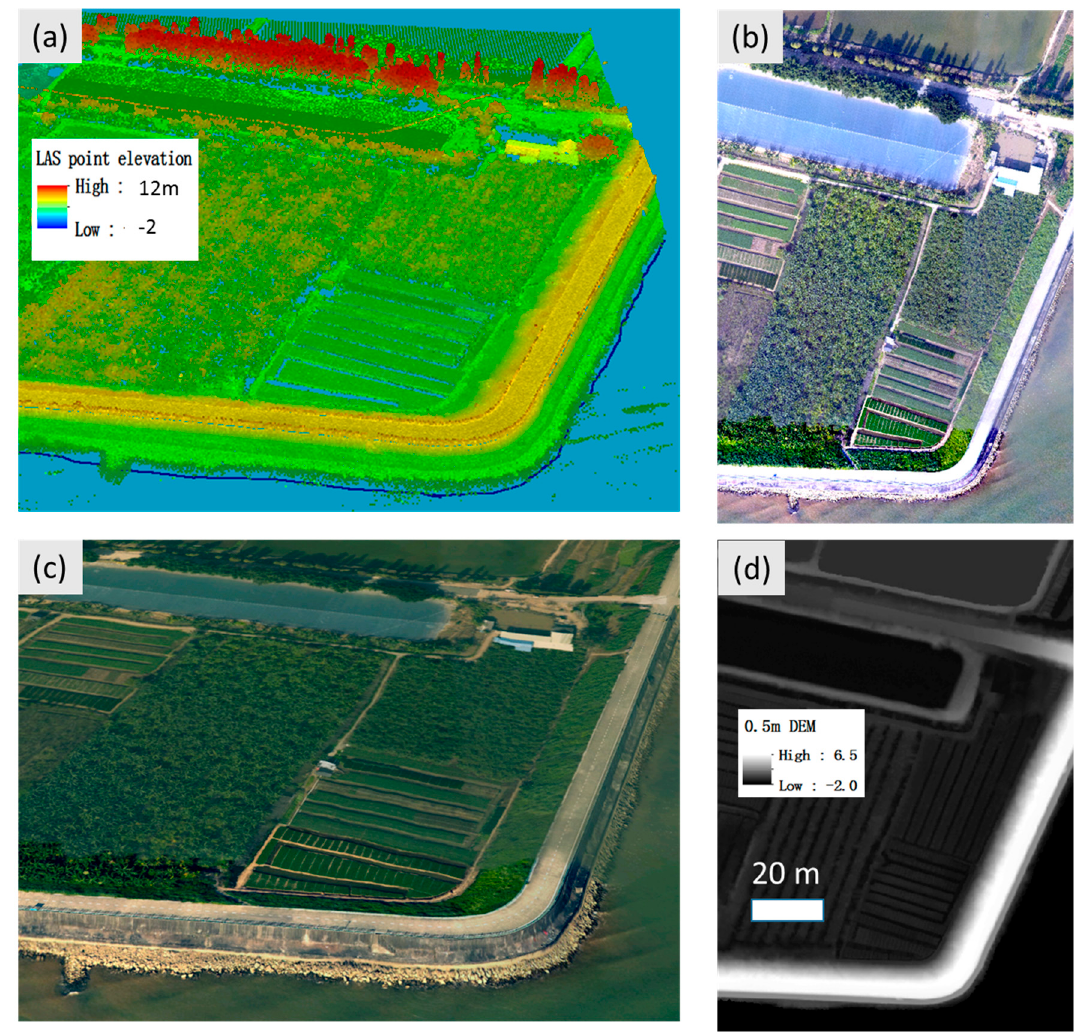
Figure 5. Demonstrations of ( a ) the original LiDAR point cloud elevation (16 points/m 2 ), ( b ) 0.05 m optical image, ( c ) levee 3D real scene model, and ( d ) 0.5 m DEM.